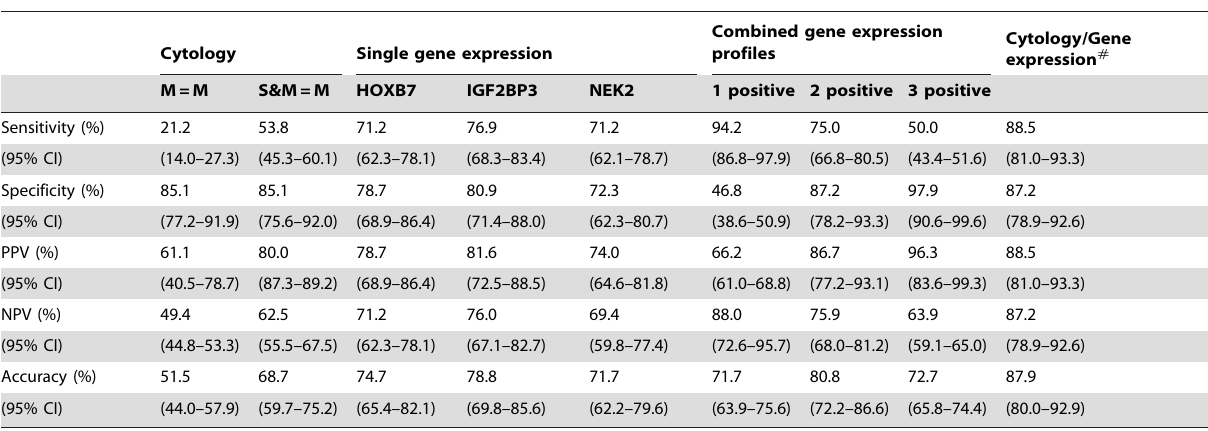
Table 5. Performance Characteristics for Patients with CCC (n=52).